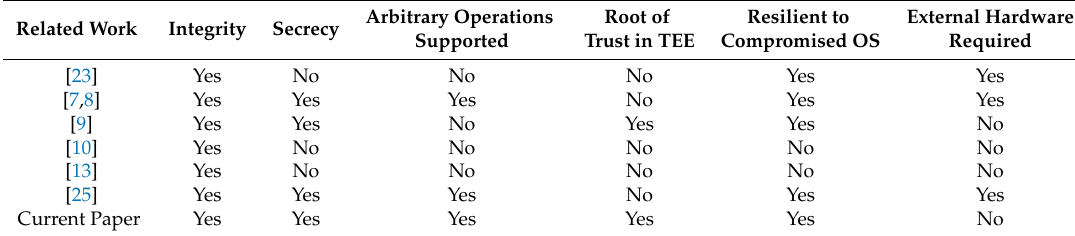
Table 1. Comparison to related